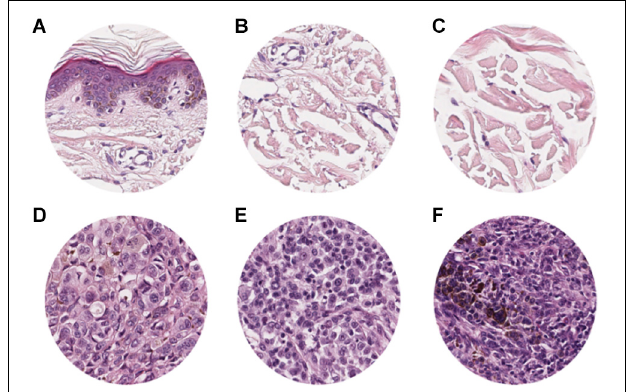
FIGURE 1 | ROI samples selected from healthy tissue (A–C) and invasive cutaneous melanoma (D–F) on a whole slide image. Each ROI was obtained at a magnification of 20 × .